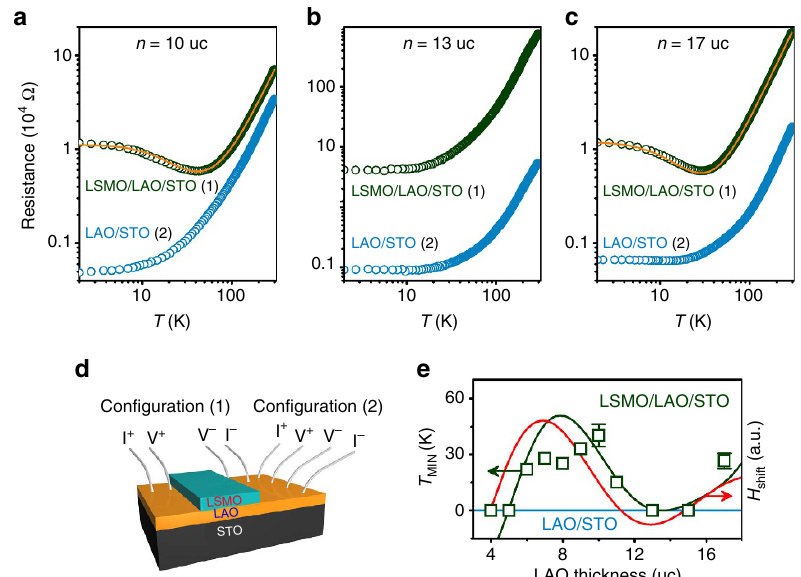
Figure 2 | Transport properties of the 2DEG at the LaAlO 3 /SrTiO 3 with La 0.67 Sr 0.33 MnO 3 strip. ( a – c ) The resistance versus temperature for 10, 13 and 17uc LaAlO 3 spacers, measured in the two configurations illustrated in d . ( e ) The temperature of resistance minimum measured in configuration (1) as a function of LaAlO 3